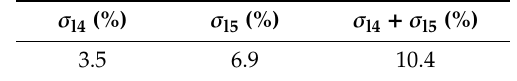
Table 12. Theoretical prestress loss of steel strands during the in-service stage.